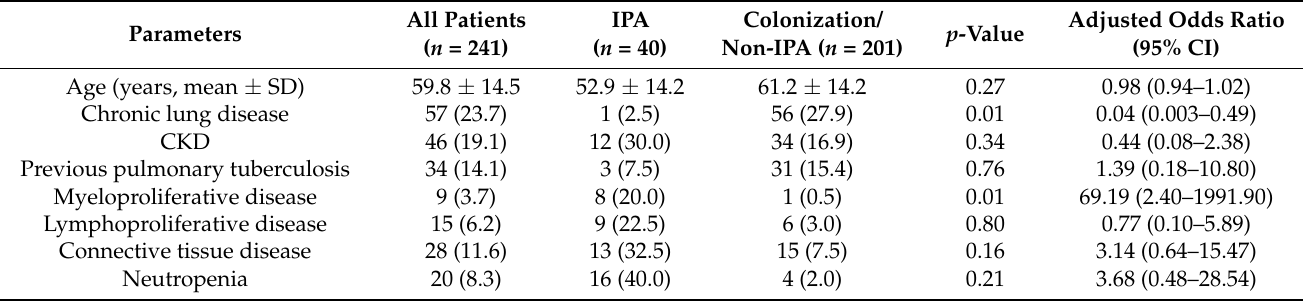
Table 3. Multivariate analysis for factors independently associated with the development of invasive